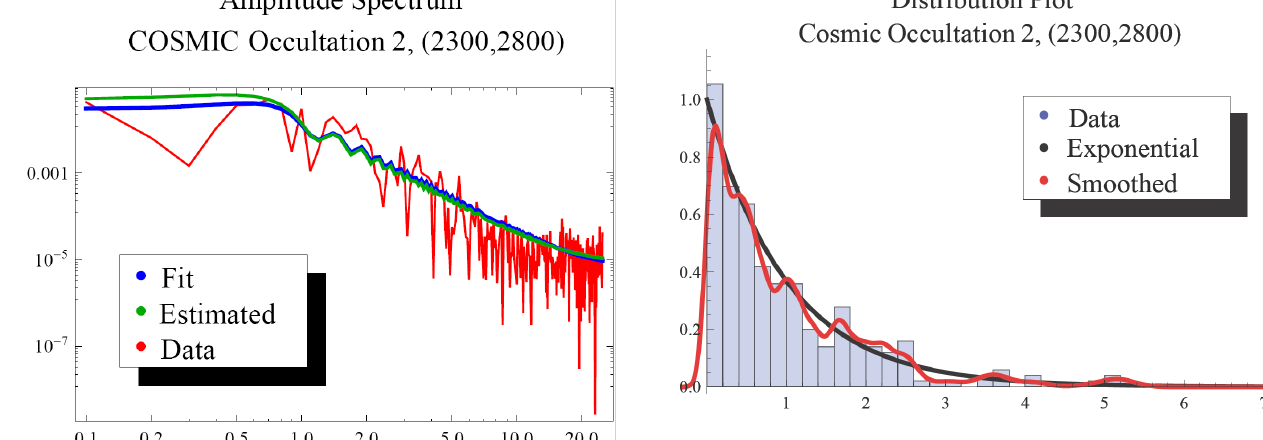
Fig. 25. Distribution of ratios for occultation